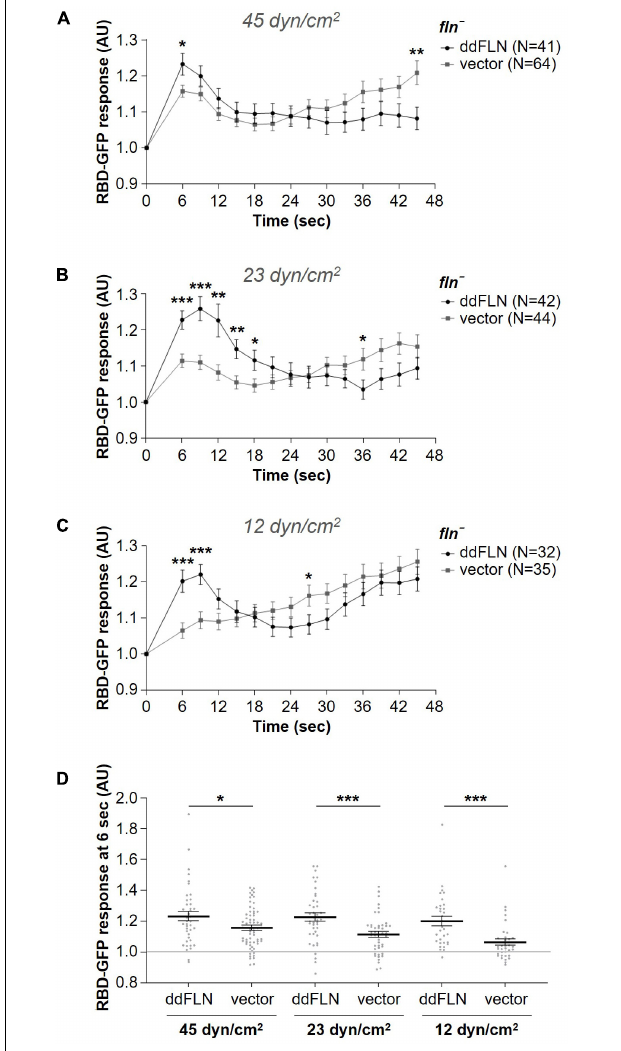
FIGURE 2 | Filamin is required for optimal activation of the signal transduction network in response to acute stimulation with shear flow. (A–C) Activation of Ras, which reflects activation of the signal transduction network, was measured by the relocalization of RBD-GFP from the cytosol to the cell cortex. fln - cells expressing RBD-GFP and either mCherry-tagged ddFLN or empty vector were imaged every 3 s by epifluorescence microscopy with a GFP filter set under 630X magnification with oil immersion. Shear flow was applied at time 0 for 2 s. The shear stress delivered to the cells was 45 dyn/cm 2 (A) , 23 dyn/cm 2 (B) , or 12 dyn/cm 2 (C) . Data is displayed as mean ± SE. Number of cells analyzed is provided in the key and was pooled from four (A) or three (B, C) independent experiments. (D) RBD-GFP response values for individual cells from panels (A–C) at the 6 s time point. Horizontal lines with error bars correspond to mean ± SE. A line at the RBD-GFP response value of 1.0 is shown as a reference to indicate basal levels at time 0. * P < 0.05, ** P < 0.01, and *** P < 0.001.